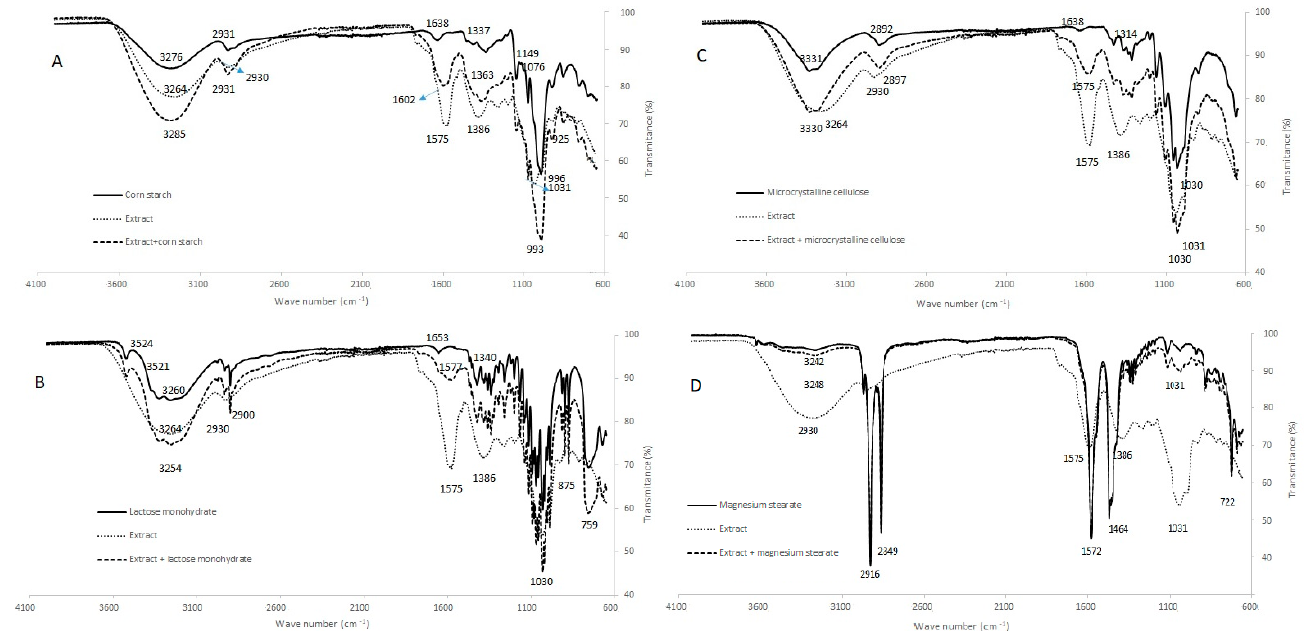
Figure 3. FTIR-ATR spectra of the extract, excipients and extract—excipient mixtures (1:1): ( A ) corn starch; ( B ) lactose monohydrate; ( C ) microcrystalline cellulose; ( D ) magnesium stearate.